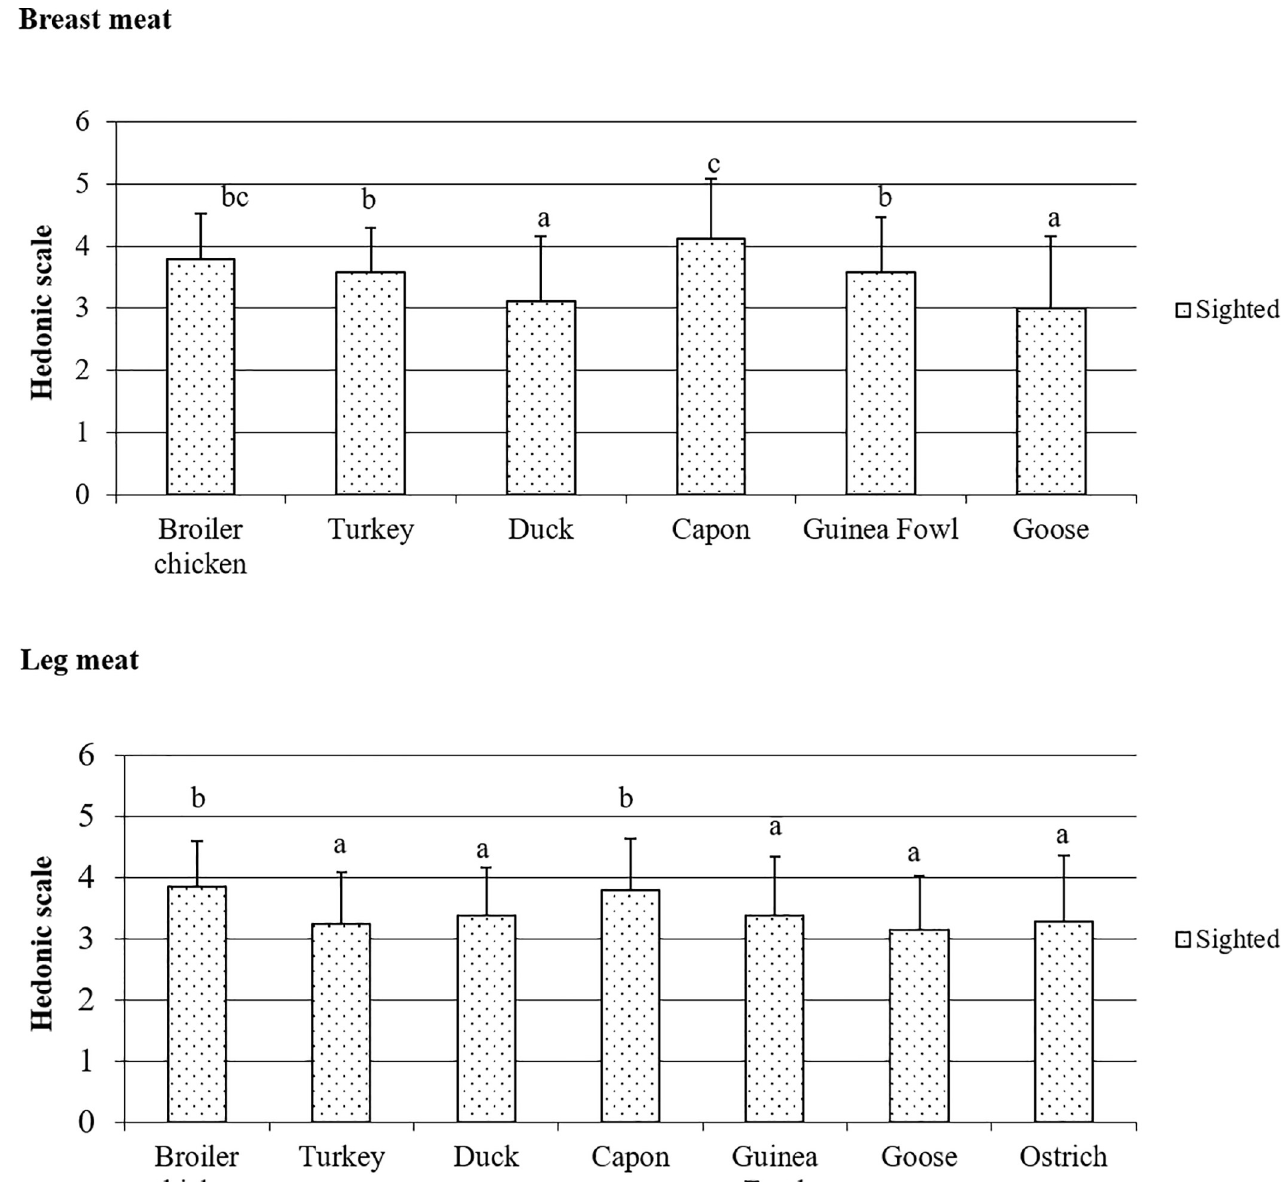
Fig 1. Poultry meat color based on the evaluation by the sighted panelists.